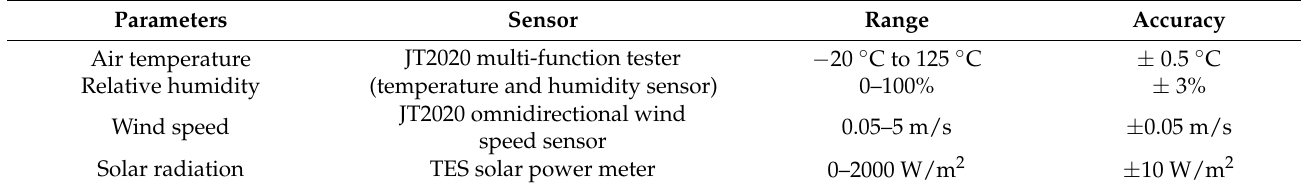
Table 3. Details of sensors used to measure meteorological parameters.